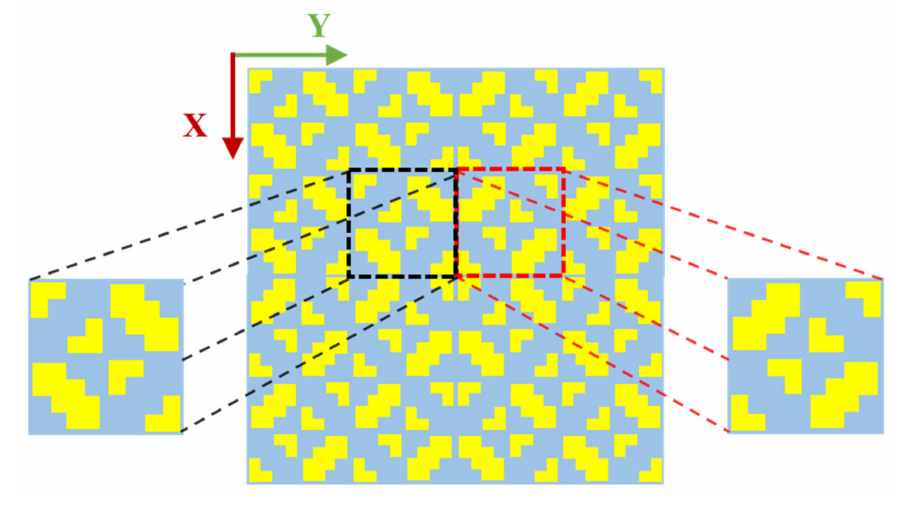
Figure 6. RCS reduction metasurface-based PCM.